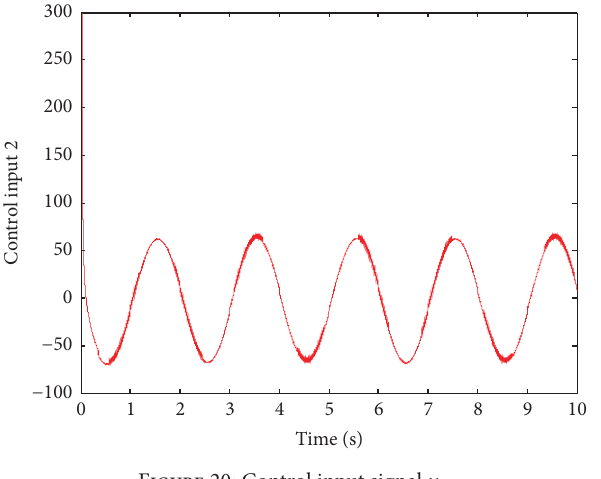
Figure 20: Control input signal 𝑢 2